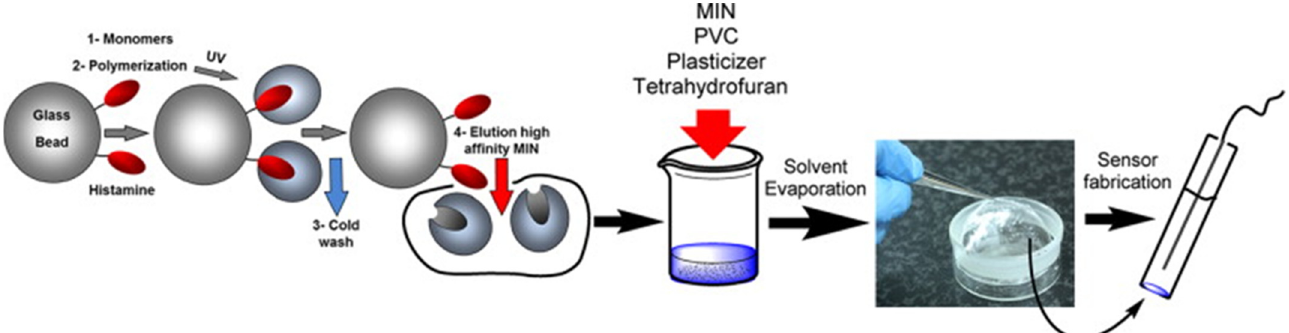
Figure 12. Manufacturing steps of a histamine-sensitive potentiometric electrode [207]. The histamine templates are immobilized on glass beads and the MIP matrix is polymerized under UV irradiation. Through stringent washing steps, one obtains molecularly imprinted nanoparticles (MINs) with high target affinity. The MINs are embedded in a PVC membrane, which serves as the endcap of an electrode filled with histamine solution of known concentration. The sensing principle is based on the intrinsic charge of histamine molecules, and, at slightly acidic pH values, the sensitivity corresponds exactly to the Nernstian limit for divalent ions. The figure is reproduced from ref. [207], Copyright 2014, with permission from Elsevier.